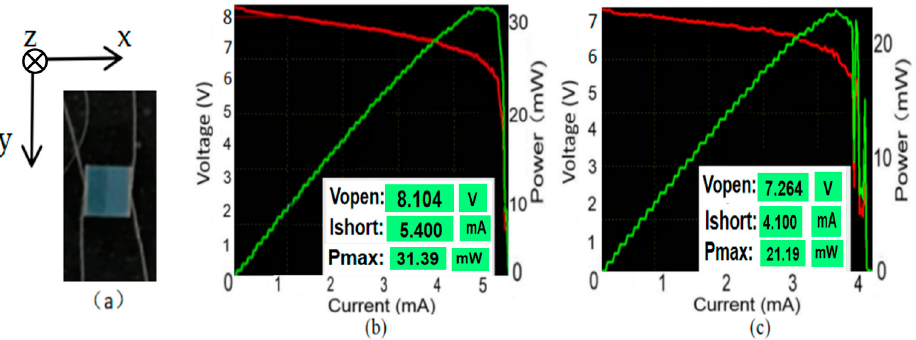
Figure 8. ( a ) Top view of a multijunction Si solar cell produced by MIH TM VMJ; its I–V and I–P characteristics when light is incident on ( b ) the front and ( c ) the back. For a cross-section of the multijunction Si solar cell in the xz-plane, see bottom right of Figure 9.